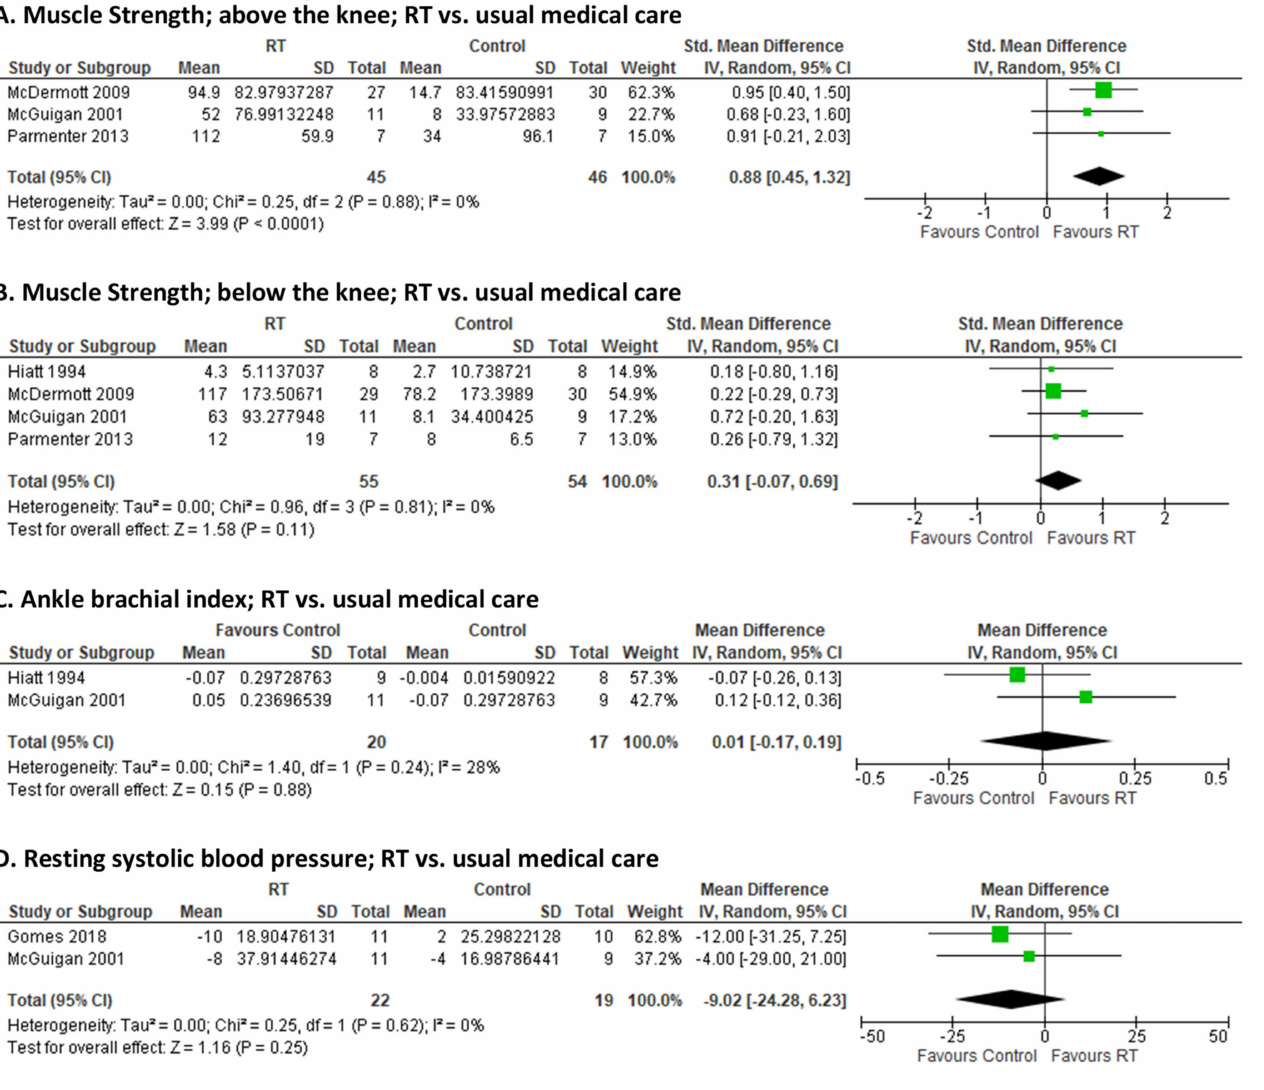
Figure 5. Pooled estimates and forest plots for supervised resistance training (RT) versus usual medical care on: muscle strength above the knee ( A ); muscle strength below the knee ( B ); ankle-brachial index ( C ); resting systolic blood pressure ( D